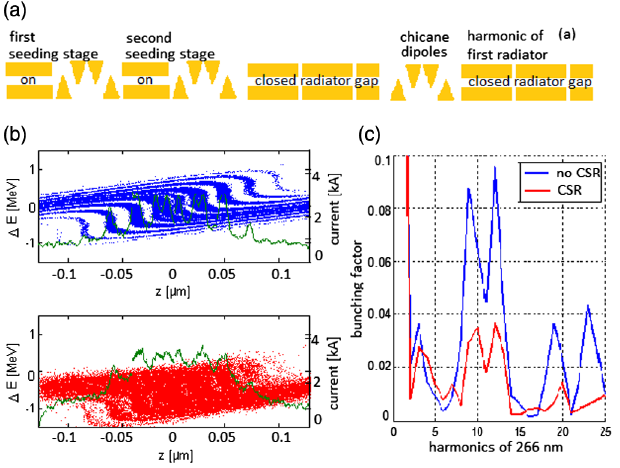
FIG. 11. The single-color LSC-EEHG scheme proposed in [59] in which energy modulation for the second EEHG stage is produced through LSC forces instead of through a seed and modulator. The harmonic content of a 20 nm seeded beam with (red) and without (blue) CSR from a 60 μ m dispersion chicane with bend radii of 14 m. A single cycle of the longitudinal phase space distribution and current distribution are plotted in (b). The seed wavelength was 266 nm and the dispersion in the first chicane was 240 μ m. The initial peak current was 1.5 kA, the electron beam energy was 730 MeV, and the initial slice energy spread was 150